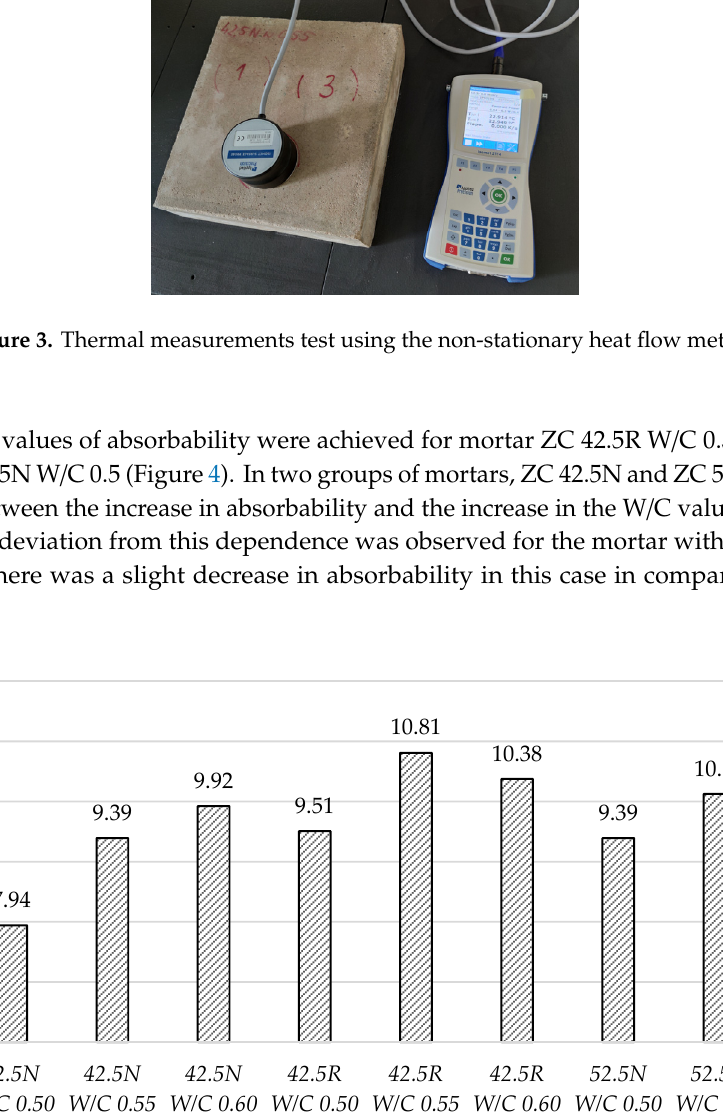
Figure 3. Thermal measurements test using the non ‐ stationary heat flow method